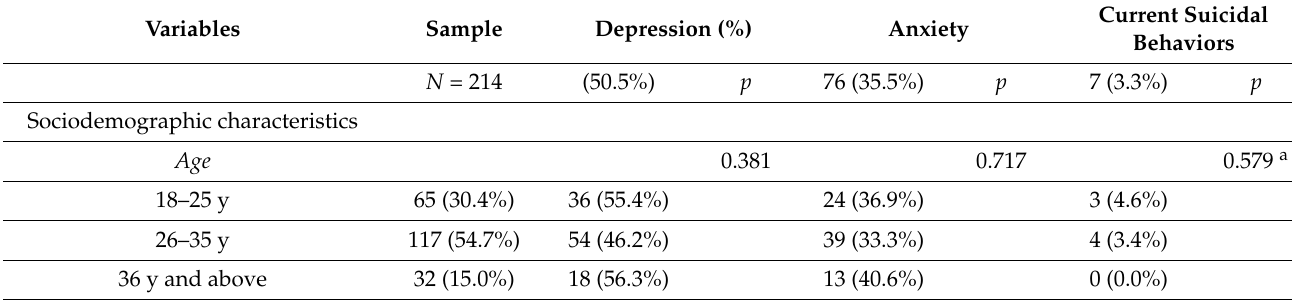
Table 1. Summary of descriptive statistics and factors associated with depression, anxiety and suicidality among preg- nant